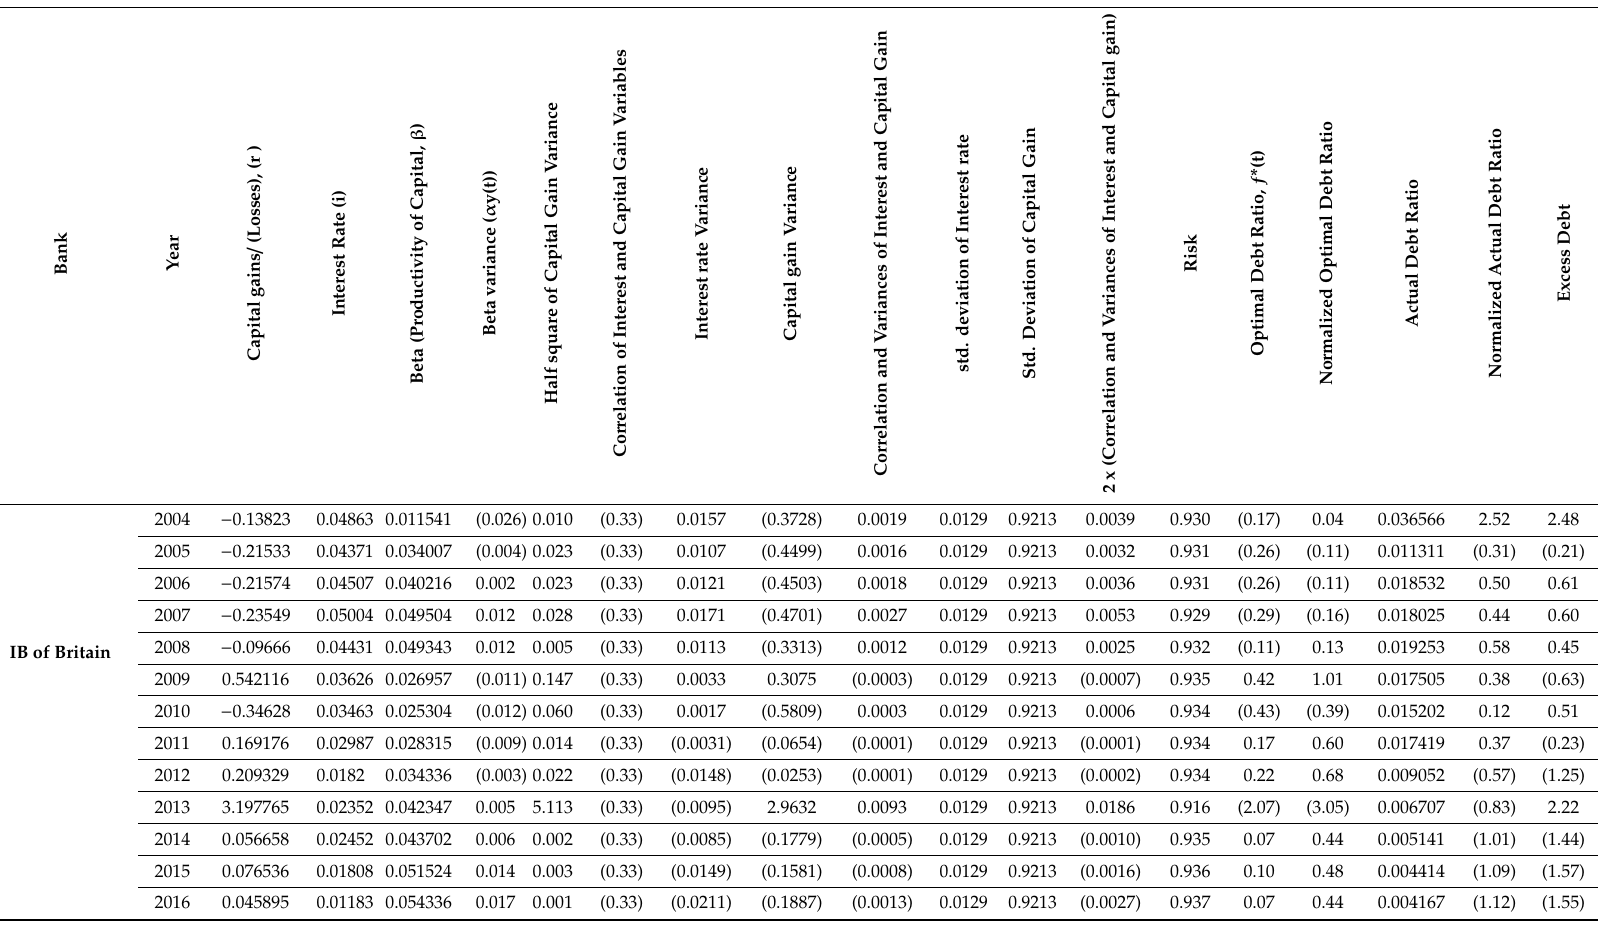
Table A21. Calculations of Optimal and Excess Debt: IB of